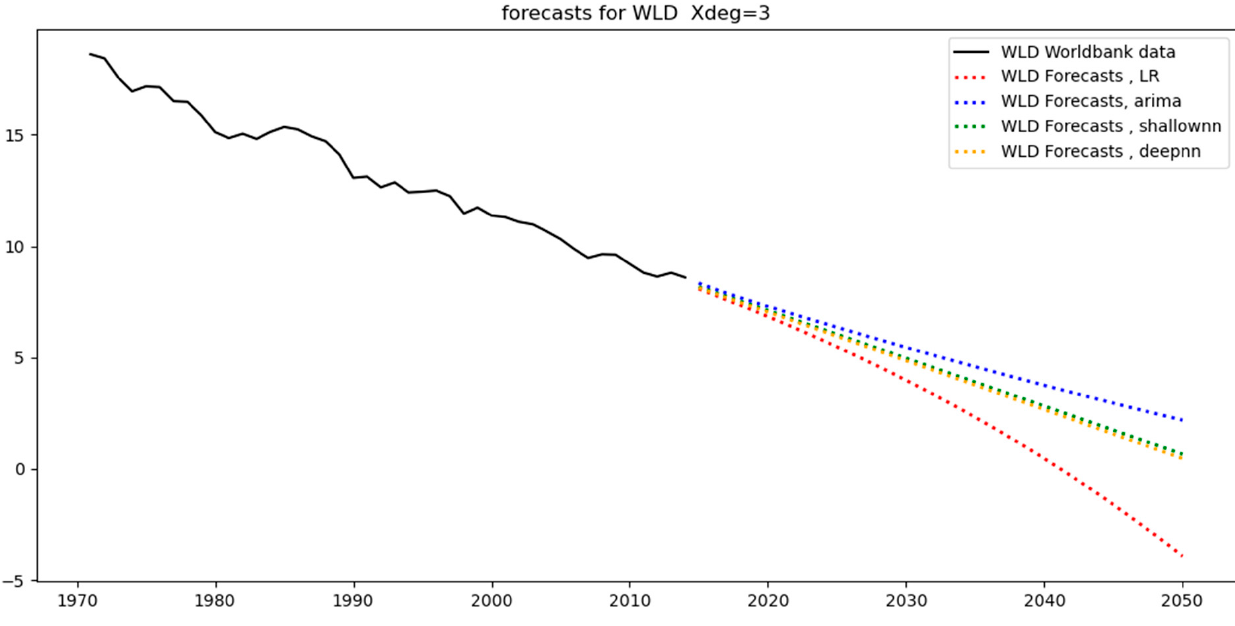
Figure 16. Forecasts for the world average (WLD), using linear regression (LR), ARIMA, shallow neural networks (shallownn), and deep neural network (deepnn) models (third-degree polynomial).